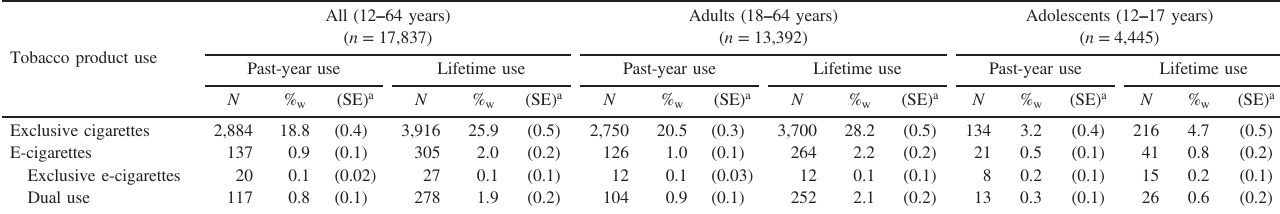
Table 2. Prevalence of past-year and lifetime use of tobacco products in the 2014 National Survey of Substance Use in Taiwan